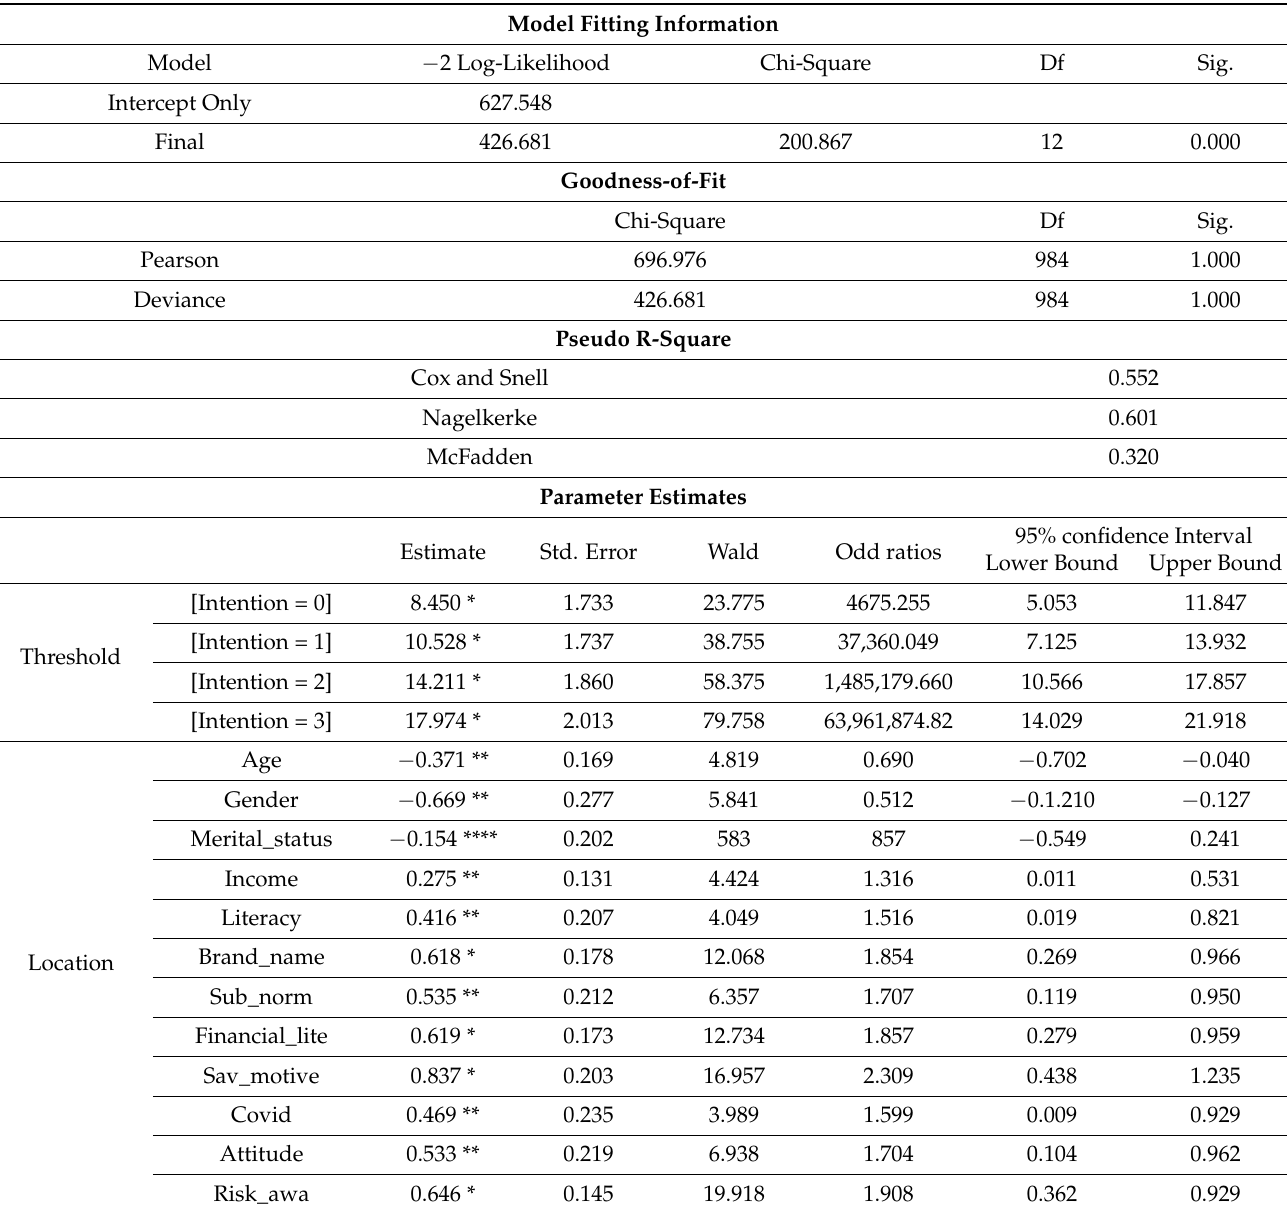
Table 8. Results of ordinal logistic model for determining factor effect on the intention to purchase life